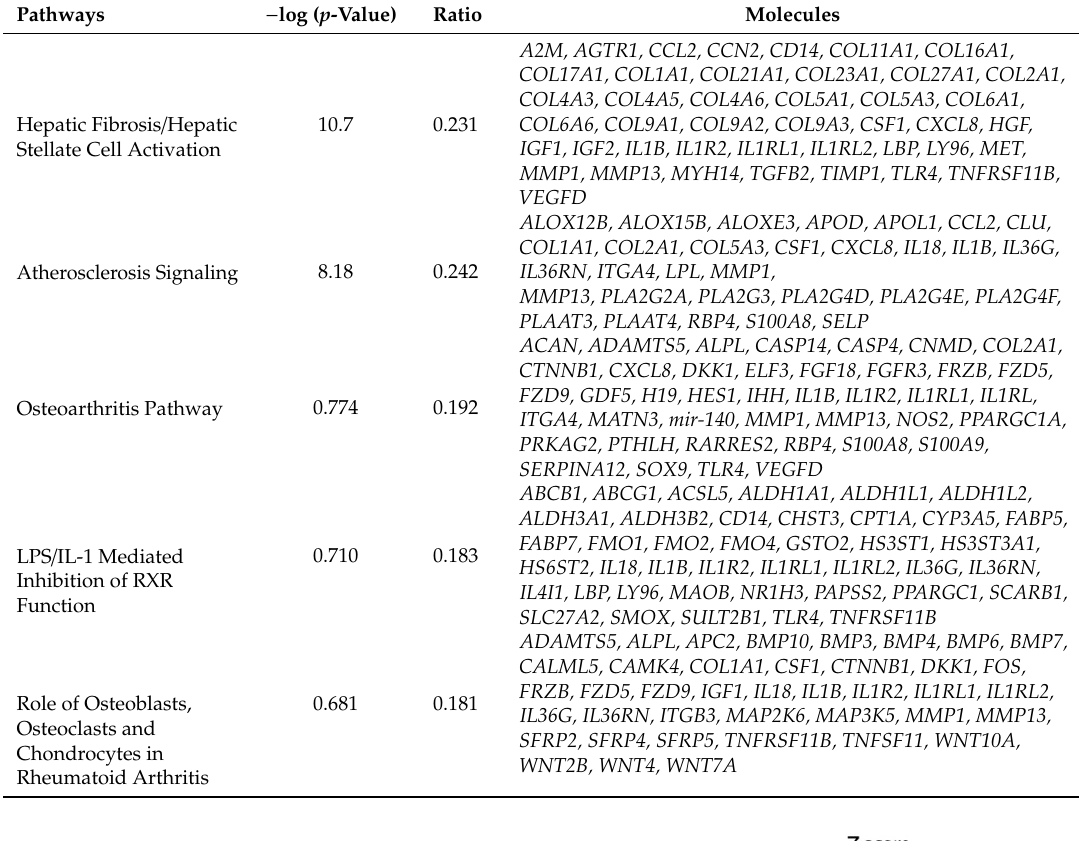
Hepatic Fibrosis / Hepatic Stellate Cell Activation